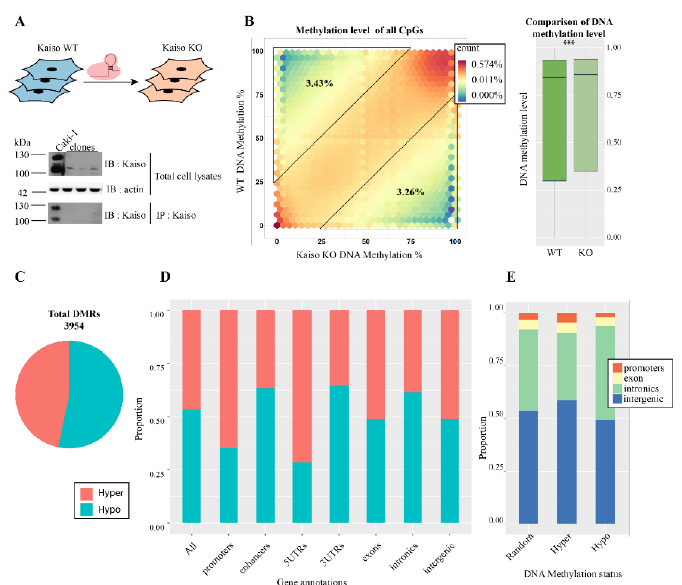
Figure 1. Whole-genome methylation in Caki1 cells and Kaiso deficient Caki1 cells. ( A ) Design of experiment, Kaiso was inactivated by CRISPR/Cas9 genome editing. ( B ) Hexagon plot showing methylation level for all CpGs ( n = 28,368,572) in Kaiso deficient cells (Kaiso KO) versus wild type cells and mean methylation level over the whole-genome (*** p -value = 0.0002481). ( C ) Relative quantities of hyper- and hypo-DMRs. ( D , E ) Relative quantities of hypo- and hyper-DMRs that overlap with different genomic